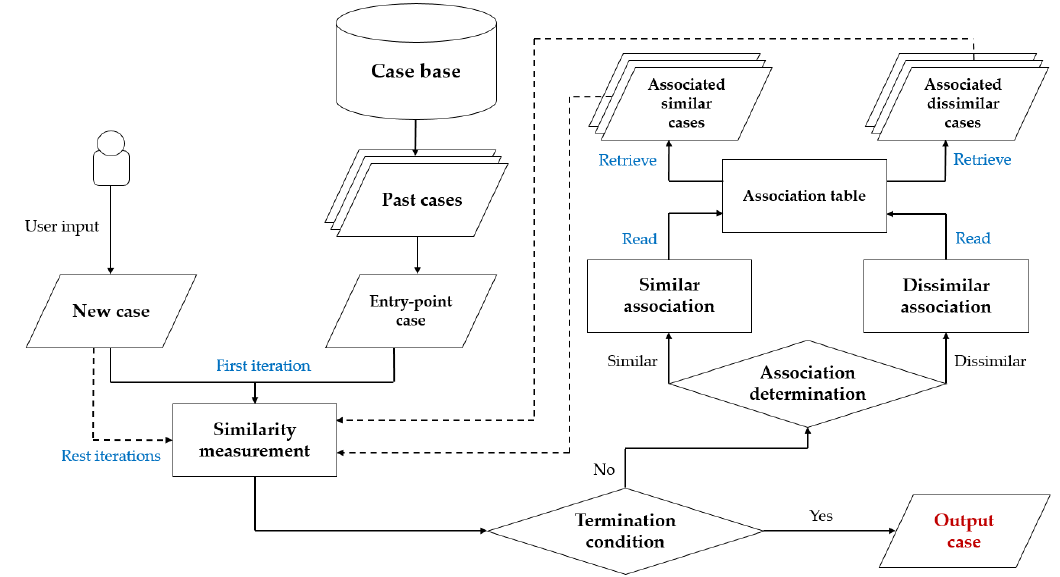
Figure 2. Workflow of the proposed case retrieval algorithm.